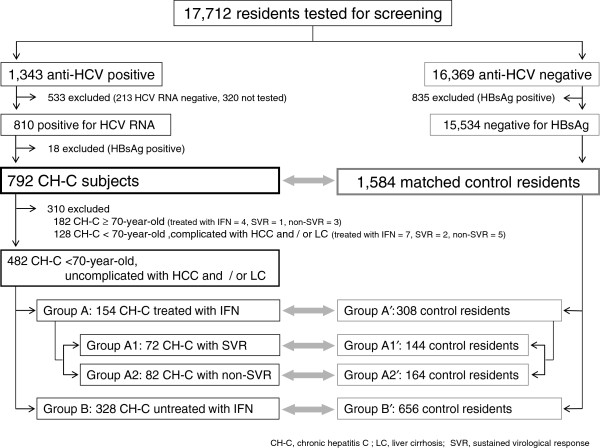
Schema for the subjects.